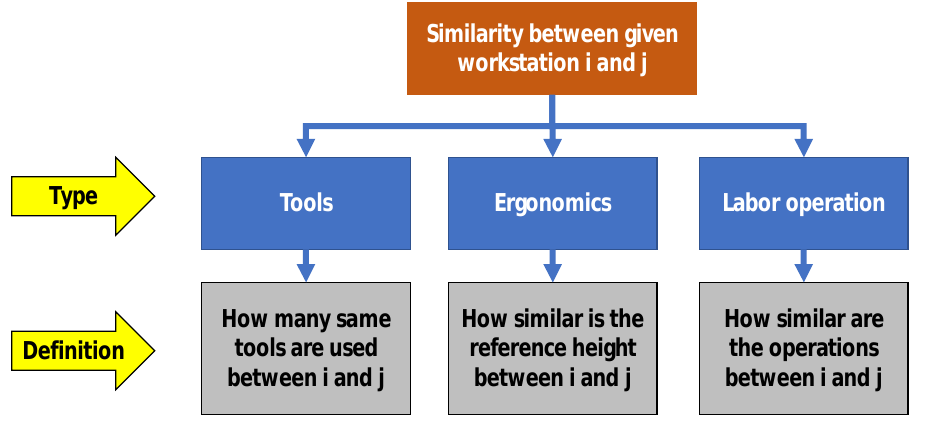
Figure 8. Three types of similarity measurement.